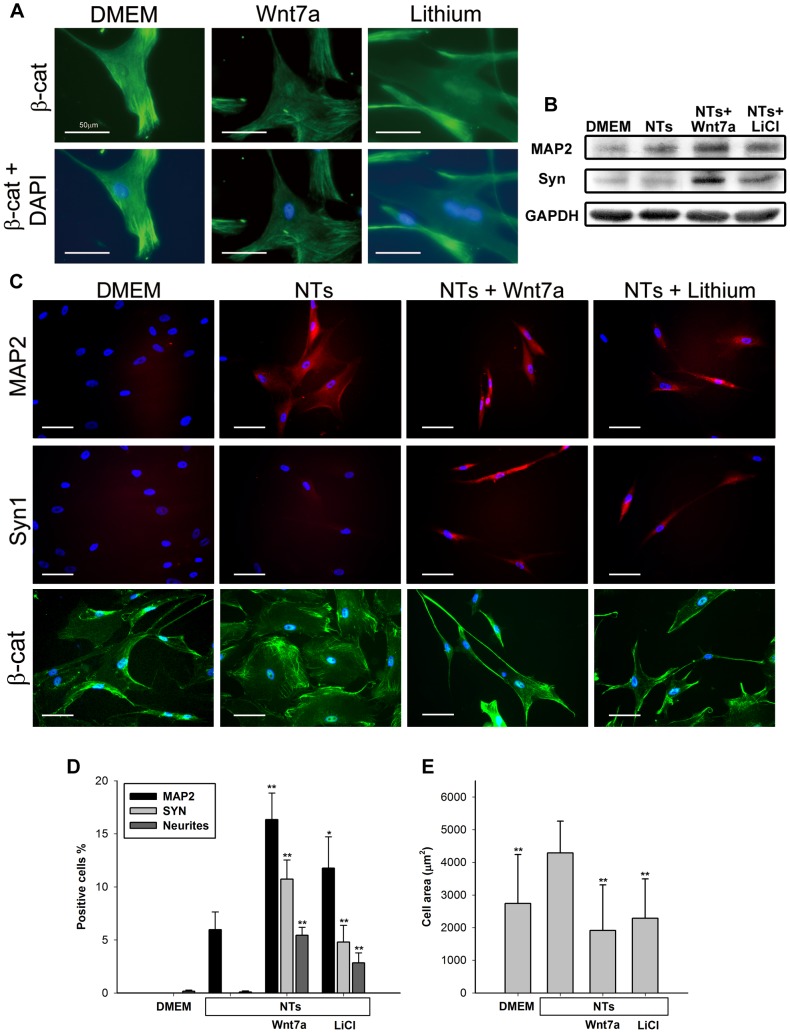
Immunostaining and immunoblotting of NT-stimulated hMSCs with Wnt7a or lithium.(A) p4 NT-treated hMSCs were stained with β-catenin (green). The NTs+Wnt7a groups were treated with NTs+Wnt7a for 24 h, and the NTs+lithium groups were treated with NTs+lithium for 24 h. 4,6-Diamidino-2-phenylindole (DAPI) (blue) was used as a counterstain. (B) p4 NT-treated hMSCs were immunoblotted with MAP2, SYN1, and GAPDH. The NT group was treated with NTs for 14 days. The NTs+Wnt7a and NTs+lithium groups were treated with NTs for 7 days first, and then with NTs+Wnt7a or lithium for 7 days. DMEM groups served as controls. (C) p4 NT-treated hMSCs were stained with MAP2 (red), SYN1 (red), and β-catenin (green). NTs groups were treated with NTs for 14 days. The NTs+Wnt7a and NTs+lithium groups were treated with NTs for 7 days first, and then NTs+Wnt7a or lithium for 7 days. DAPI (blue) was used as a counterstain. DMEM groups served as the control. The white bar represents 50 µm. (D) Percentages of MAP2-positive cells, SYN1-positive cells, and neurite-positive cells among all DAPI-positive cells. All data are presented as the mean ± SD. * p<0.05, ** p<0.01 (all vs. NTs). (E) Cell areas were calculated by β-catenin-positive cells from (B).